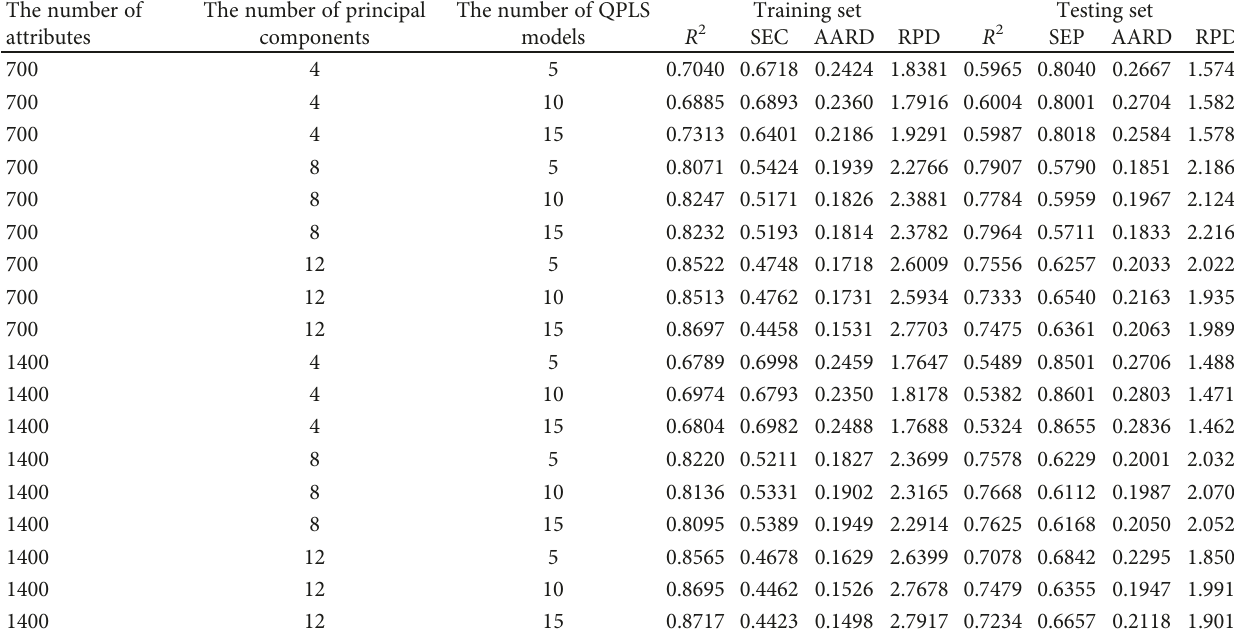
Table 5: The results of the k QPLS-SVR models for quanti fi cation of the relative content of Pst DNA in wheat leaves in the incubation period built when VN was used as the preprocessing method of the original near-infrared spectra.